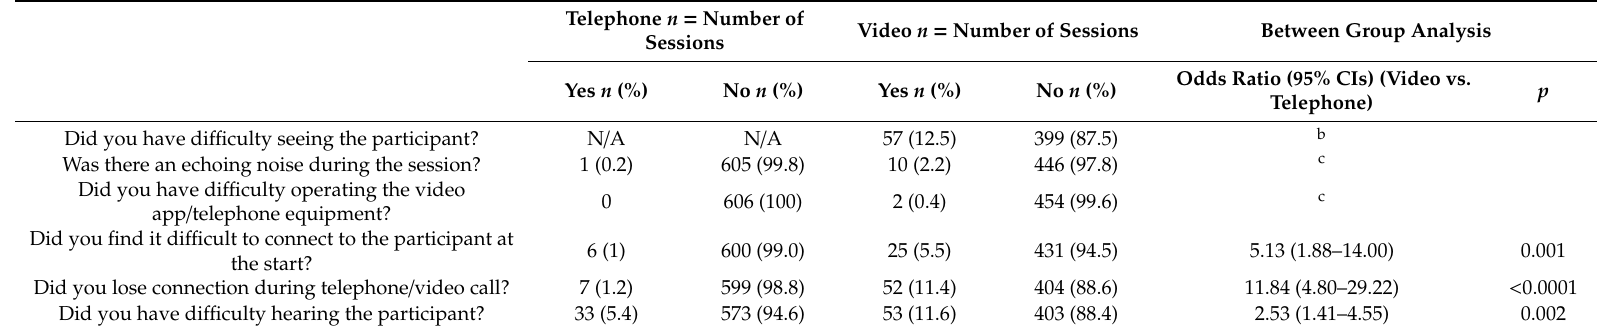
Table 2. Connectivity of video sessions and telephone sessions in rural and remote locations a